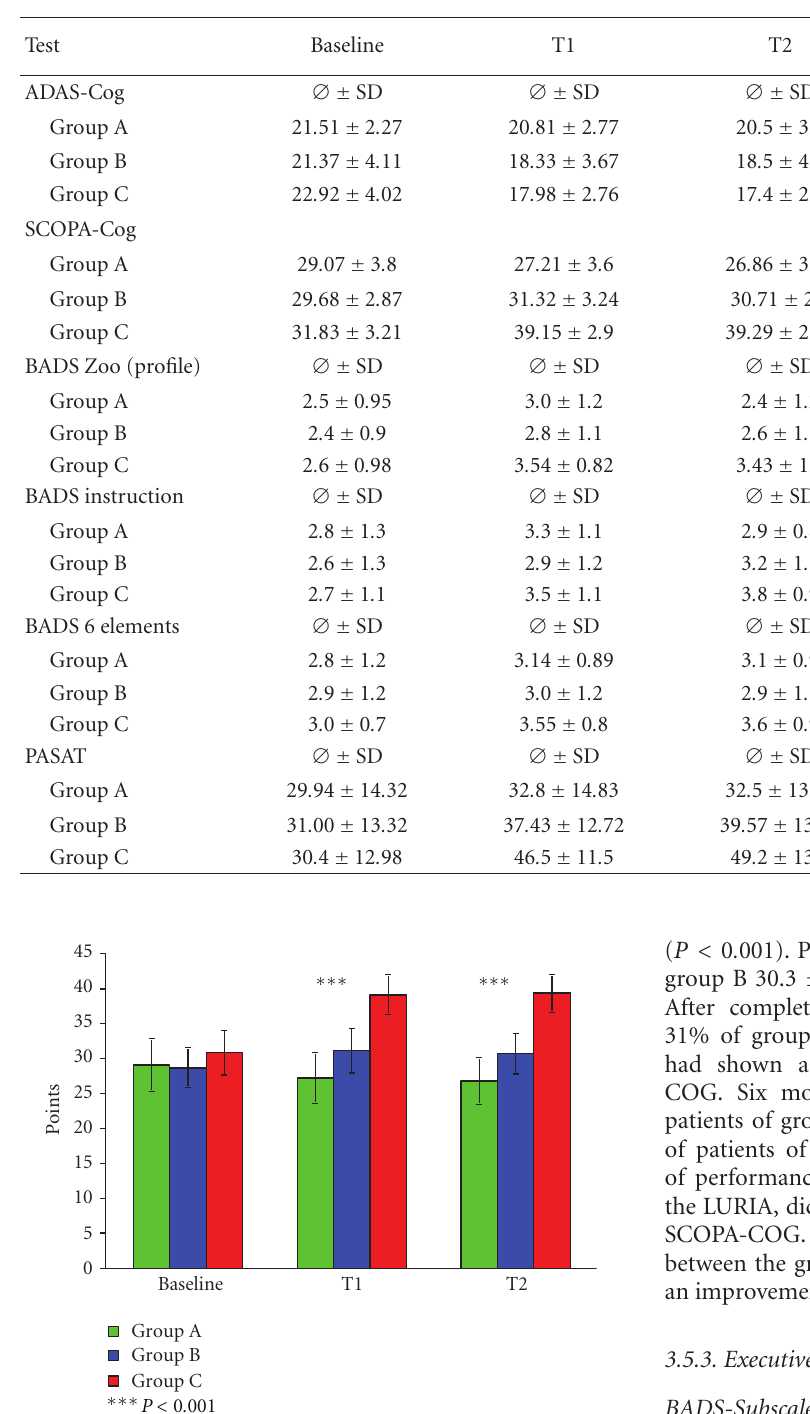
Table 6: Summary of neuropsychological test results.